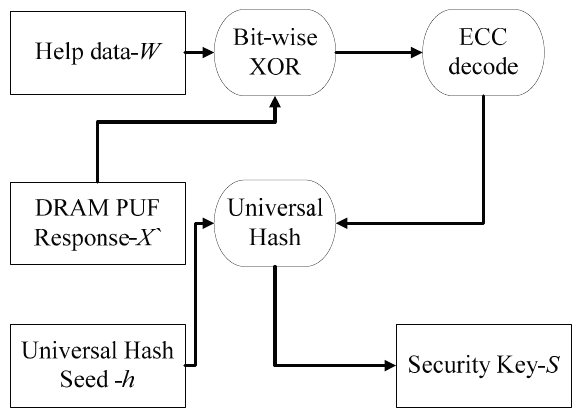
Figure 4. The flow chart of key reconstruction